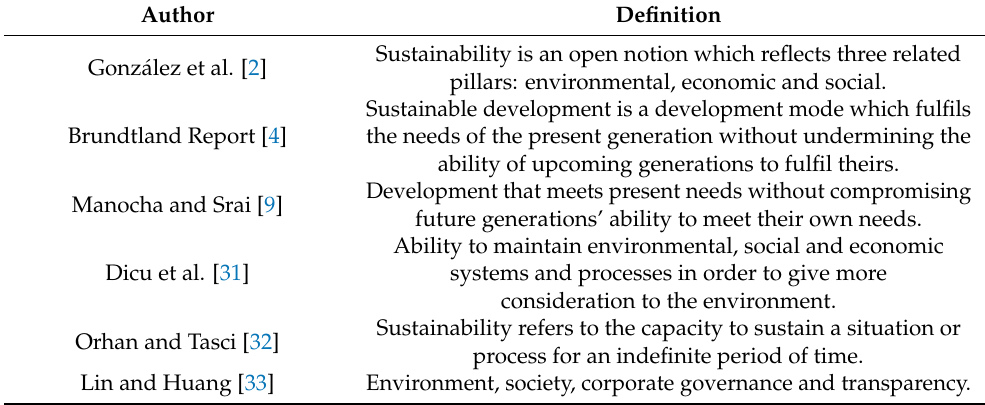
Table 1. Definition of sustainable development.